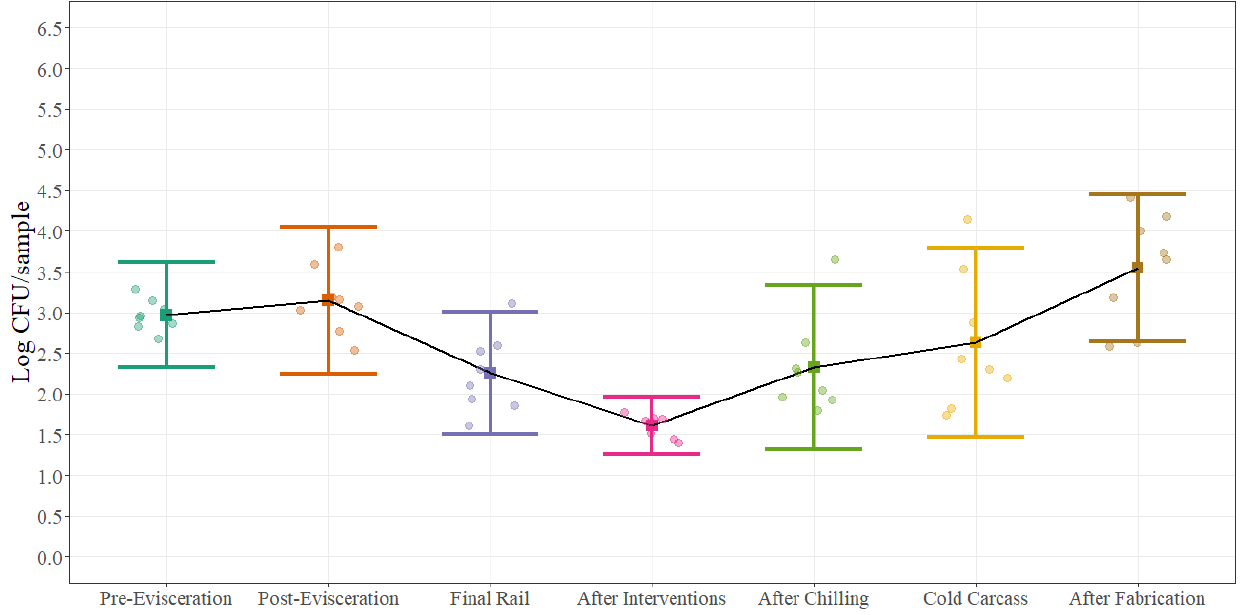
Figure 5. Statistical microbial process control for Enterobacteriaceae (EB) (Log CFU/sample; equivalent to Log CFU/100 cm 2 ) at different sampling locations on the beef processing line. Solid squares represent the mean of each sampling point for all carcass regions and error bars represent ±3 standard deviations around the mean using a sample size of 12 swabs for each microorganism. The black solid line represents the change on the average of each sampling point throughout the beef processing line for each microorganism. The points represent the actual data points.